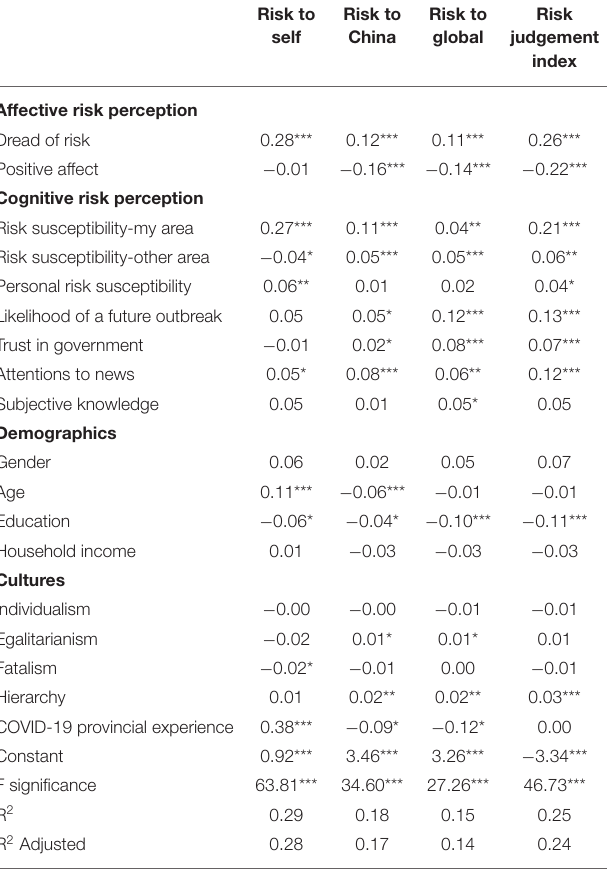
TABLE 2 | Linear regressions of risk judgement and survey of public reactions to COVID-19, China, 2020.